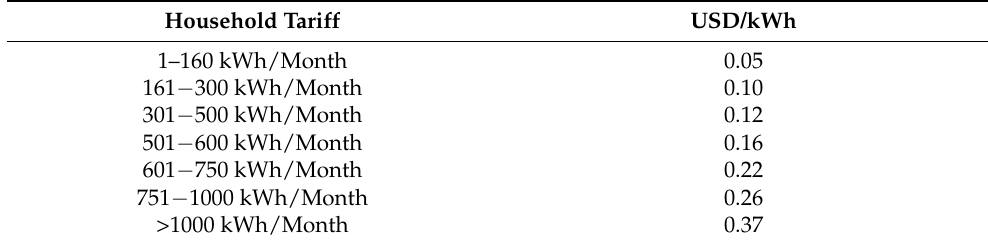
Table 1. Tariffs for monthly energy consumption by